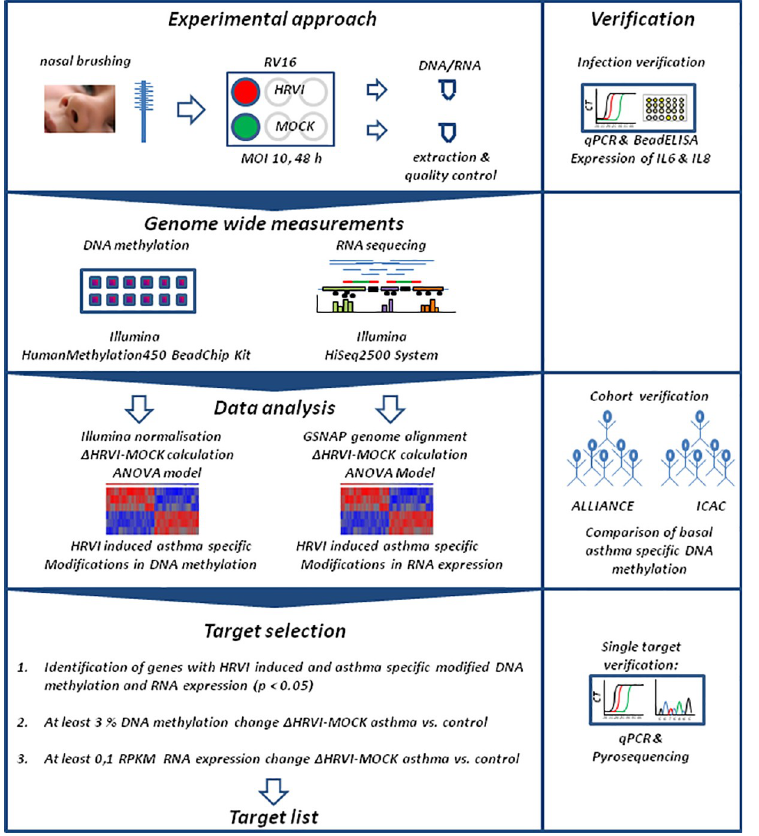
Fig 1. Study design and data analysis